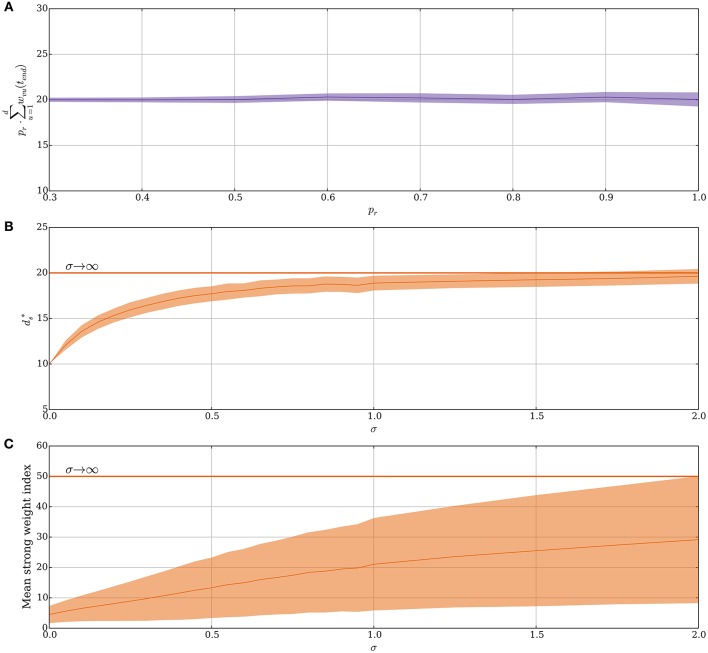
Noisy input and the random order assumption in the model without leak (Section 3.1.2). (A) The stable state ds* scales by 1/pr for probabilistic synapses. The initial value of ds is set to 20/pr for each pr and the plot shows the mean value of ds · pr after 50 weight updates over 100 trials. (B–C) From a fixed order to a random order. Spike order distributions that are not uniform are considered in these panels. The parameter σ brings them from a fixed order (σ = 0) to a uniform order (σ → ∞). (details are explained in Section 3.1.2). Initially, each synapse is strong independently, with probability 4θv/d. (B) Small variability brings the stable state ds* close to same state as when the spike order is uniform. (C) The plasticity mechanism prefers early neurons when σ is small. This is reflected by the mean index of the strong synapses, which are indexed from 1 to d in ascending order of expected spike time. However, as σ increases, the early neurons become less distinguishable from later neurons. In (B,C) each data point is the mean of 250 trials, where for each trial 250 weight updates are simulated. For all panels, the plasticity parameters are chosen as in Table 1 and the envelopes represent standard deviation estimates.